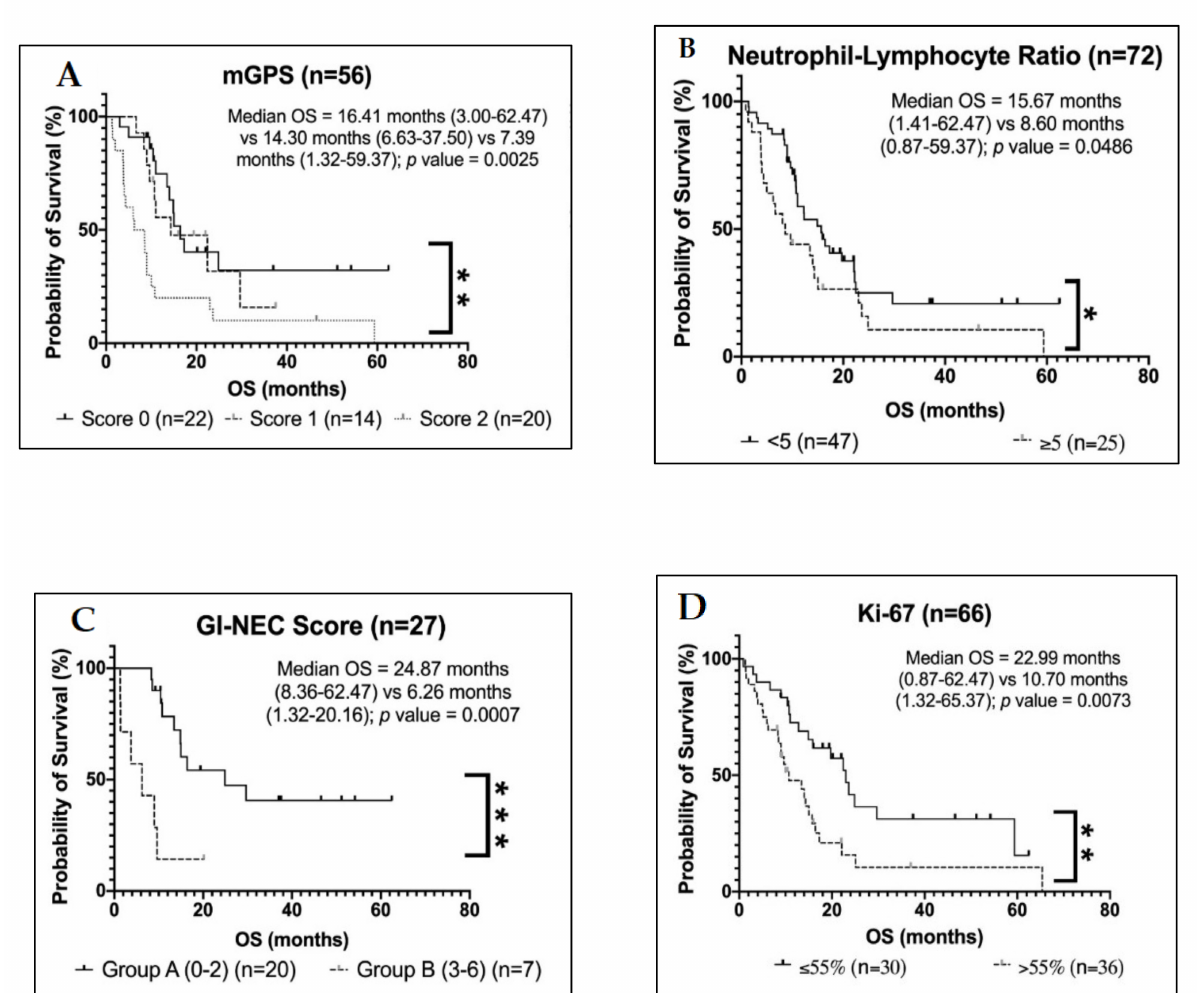
Figure 1. Kaplan–Meier survival curves of OS using different prognostic scores in the entire patient cohort. G3-NETs and NECs were divided into groups defined by different prognostic scores: modified Glasgow prognostic score (mGPS) ( A ); neutrophil-lymphocyte ratio (NLR) ( B ); gastrointestinal neuroendocrine carcinoma (GI-NEC) score ( C ) and Ki-67 using 55% as the cut-off ( D ). Median OS, range and log-rank test p value are reported; p < 0.05 was regarded as significant. * p < 0.05, ** p < 0.01, *** p <